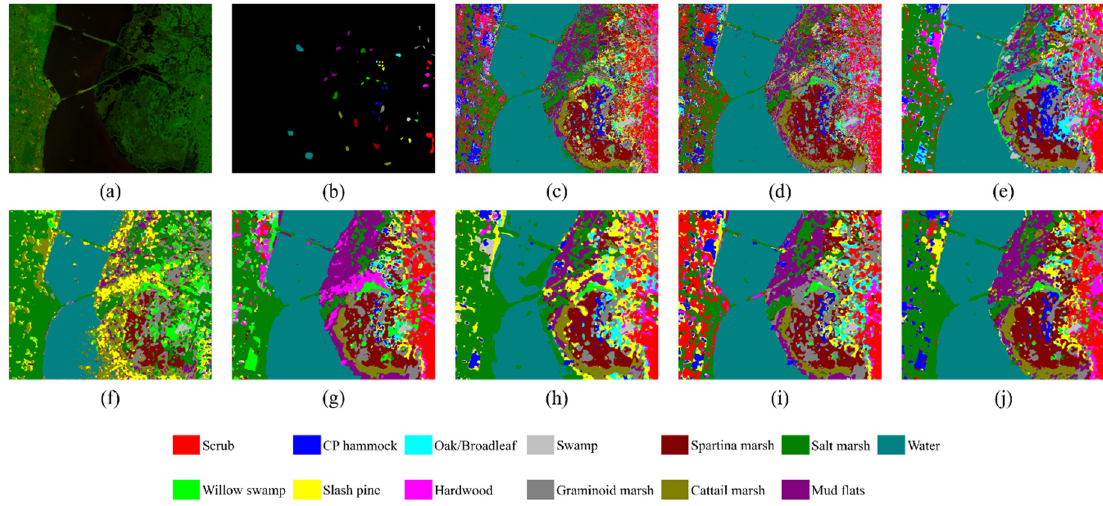
Figure 6. Classification maps of the different models for PU data set: ( a ) False-color image. ( b ) Ground-truth. ( c ) SVM ( d ) MLP ( e ) pResNet. ( f ) SCFR-CNN. ( g ) SSRN. ( h ) SSDC. ( i ) FDSSC. ( j ) DPSCN.